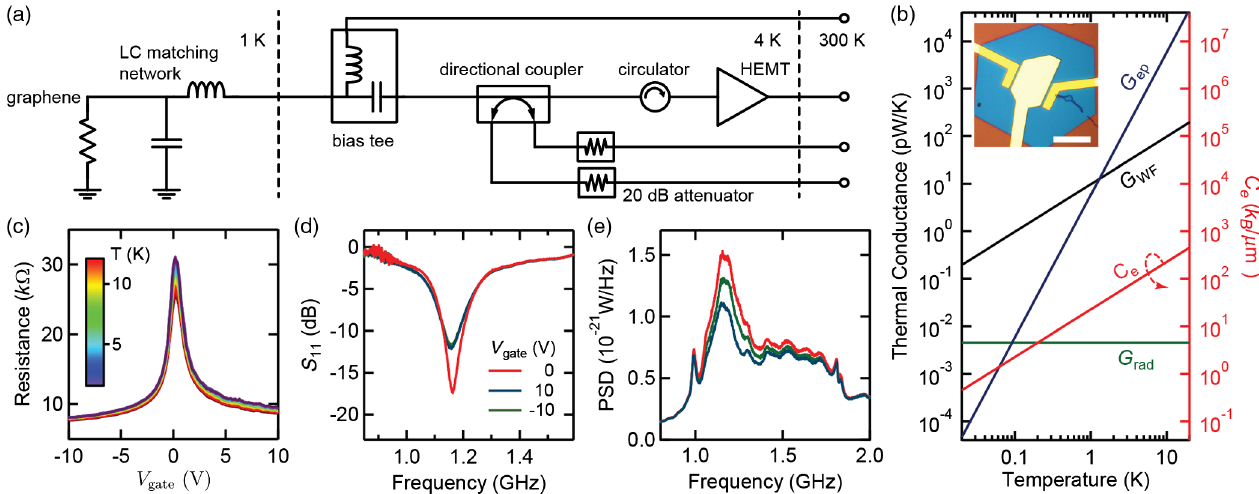
FIG. 1. (a) The measurement circuit: graphene (represented by a resistor), impedance matched with a 1.161 GHz resonant, lithographic LC network (NbTiN film, T c ¼ 13 : 5 K ), and connected to a HEMT amplifier. (b) The expected thermal conductances ; G ; G ) and heat capacity versus temperature for a bandwidth of 80 MHz, n ¼ 10 11 cm (cid:2) 2 , and A ¼ 10 (cid:2) 10 m 2 . The inset ( G WF ep rad shows an optical micrograph of the graphene sample. The scale bar is 15 (cid:1) m long. (c) The two-terminal resistance of the graphene versus gate voltage, taken from 1.65–12 K. (d) The reflected microwave response versus gate voltage. The absorption dip at 1.161 GHz shows that the graphene is well matched to 50 (cid:2) in an 80-MHz band. (e) Spectra of the measured noise power taken at various sample temperatures, demonstrating the Johnson-noise signal of the graphene in the impedance-matching